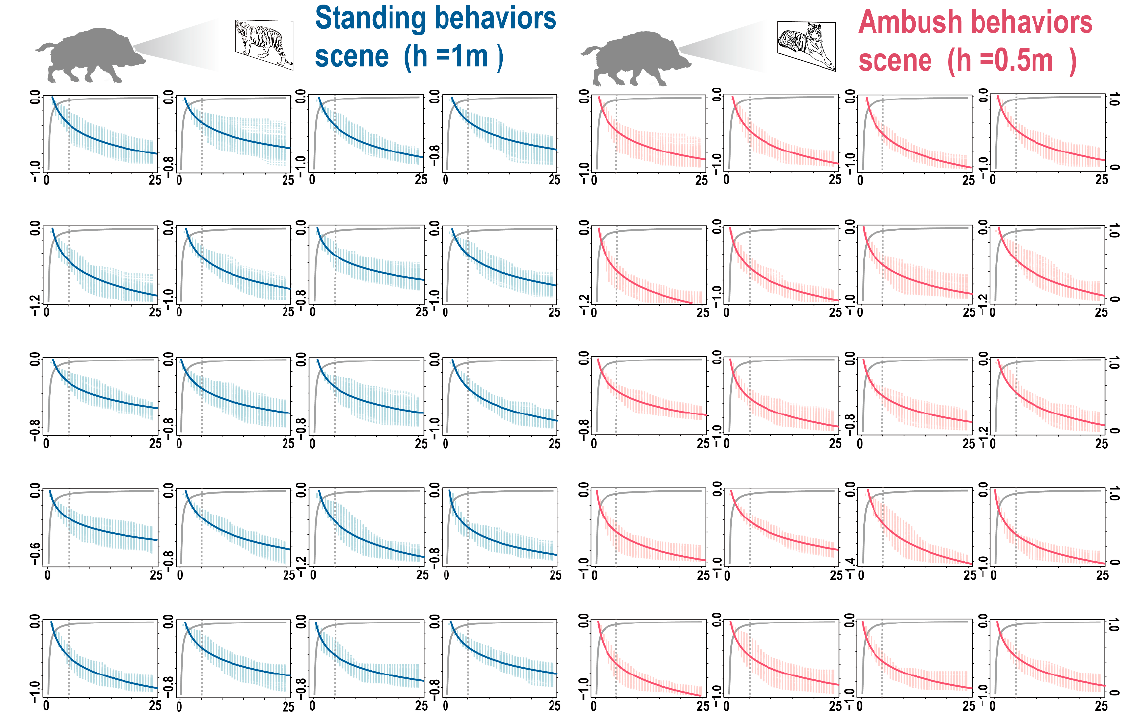
Figure 4. Pattern of visibility change with distance. Within each sample, the change pattern between distance and visibility conforms to a logarithmic curve (Visibility= a – b × log (Distance), p < 0.05, R 2 > 0.7). The gray line perpendicular to the X axis is 5 m.